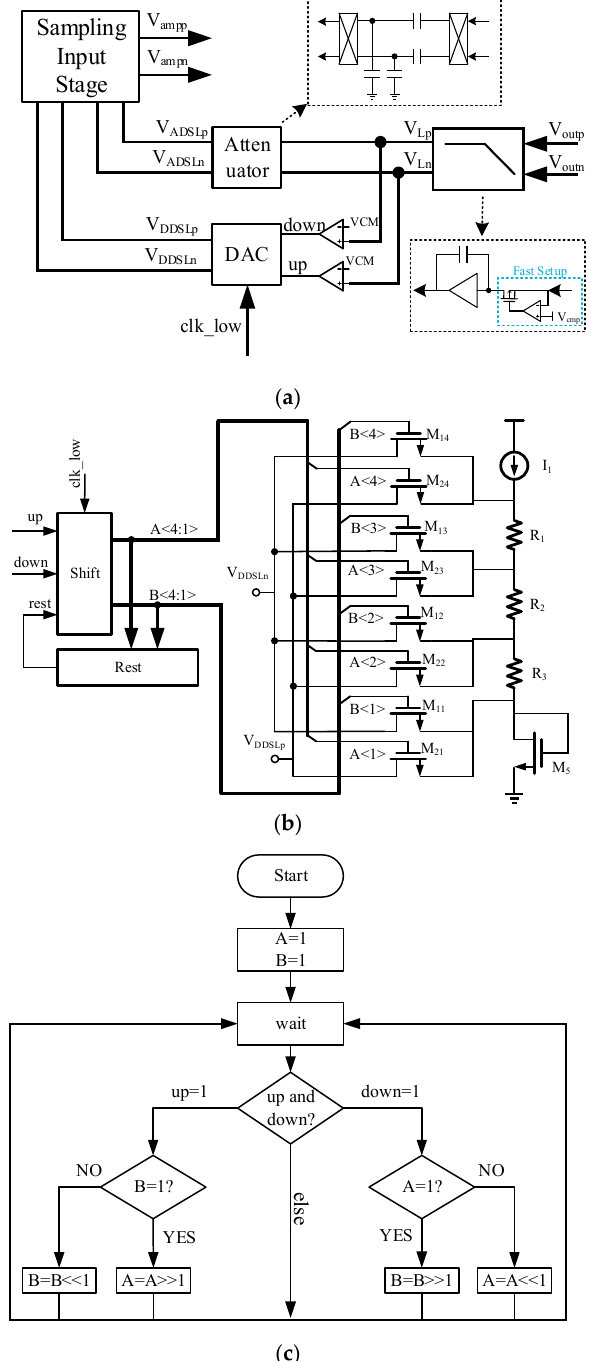
Figure 7. ( a ) Circuit implementation of the digital-analog hybrid DSL, ( b ) the digital-to-analog converter (DAC) of the digital DSL, ( c ) the shift of the DAC flow